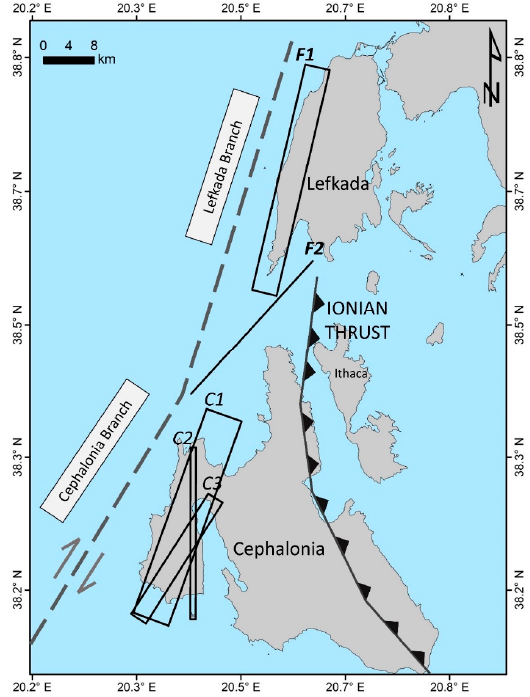
Figure 9. The configuration of the Cephalonia–Lefkada Transform Fault (CFT) zone with the two branches: Cephalonia and Lefkada. The black rectangles outline the faults. F1 and F2 are the sources of the November 2015 earthquake sequence. C1 to C3 are the faults that ruptured during the January – February 2014 earthquakes [20,27]. The CTF is a wide off- and on-shore multi-segmented fault zone; F2 is a structure that separates the CTF into the so-called “Lefkada” and “Cephalonia” branches.